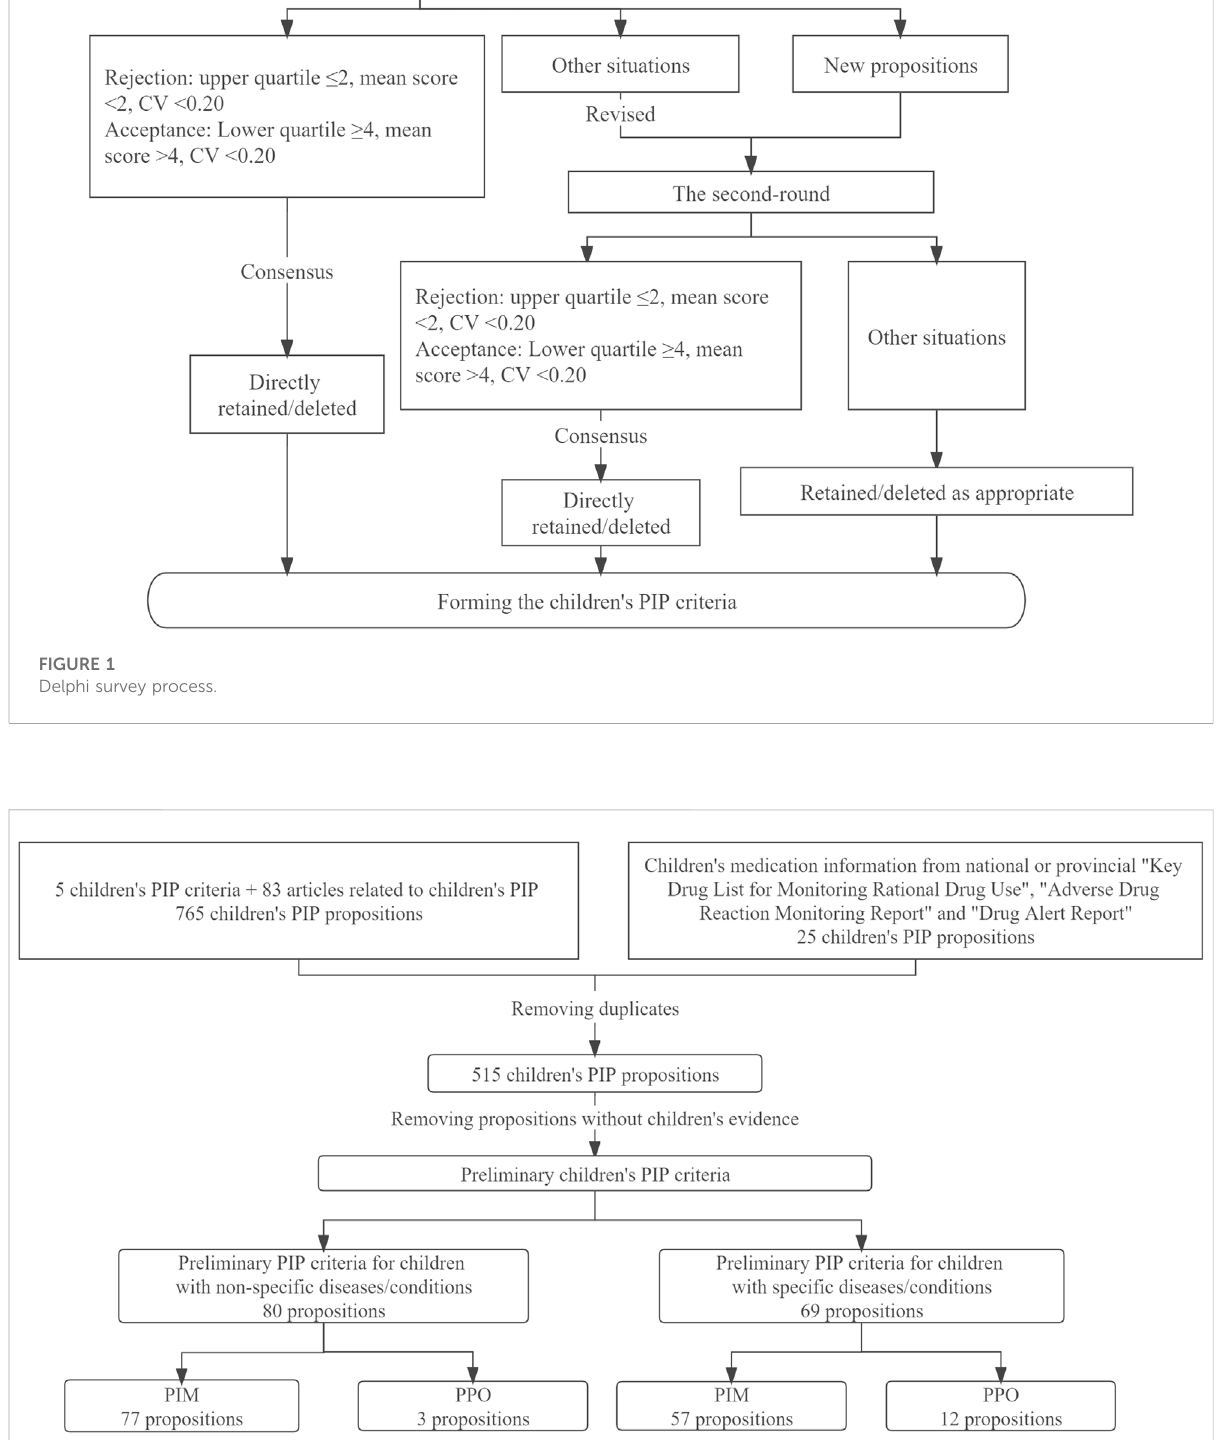
FIGURE 2 Formation process of the preliminary children ’ s PIP